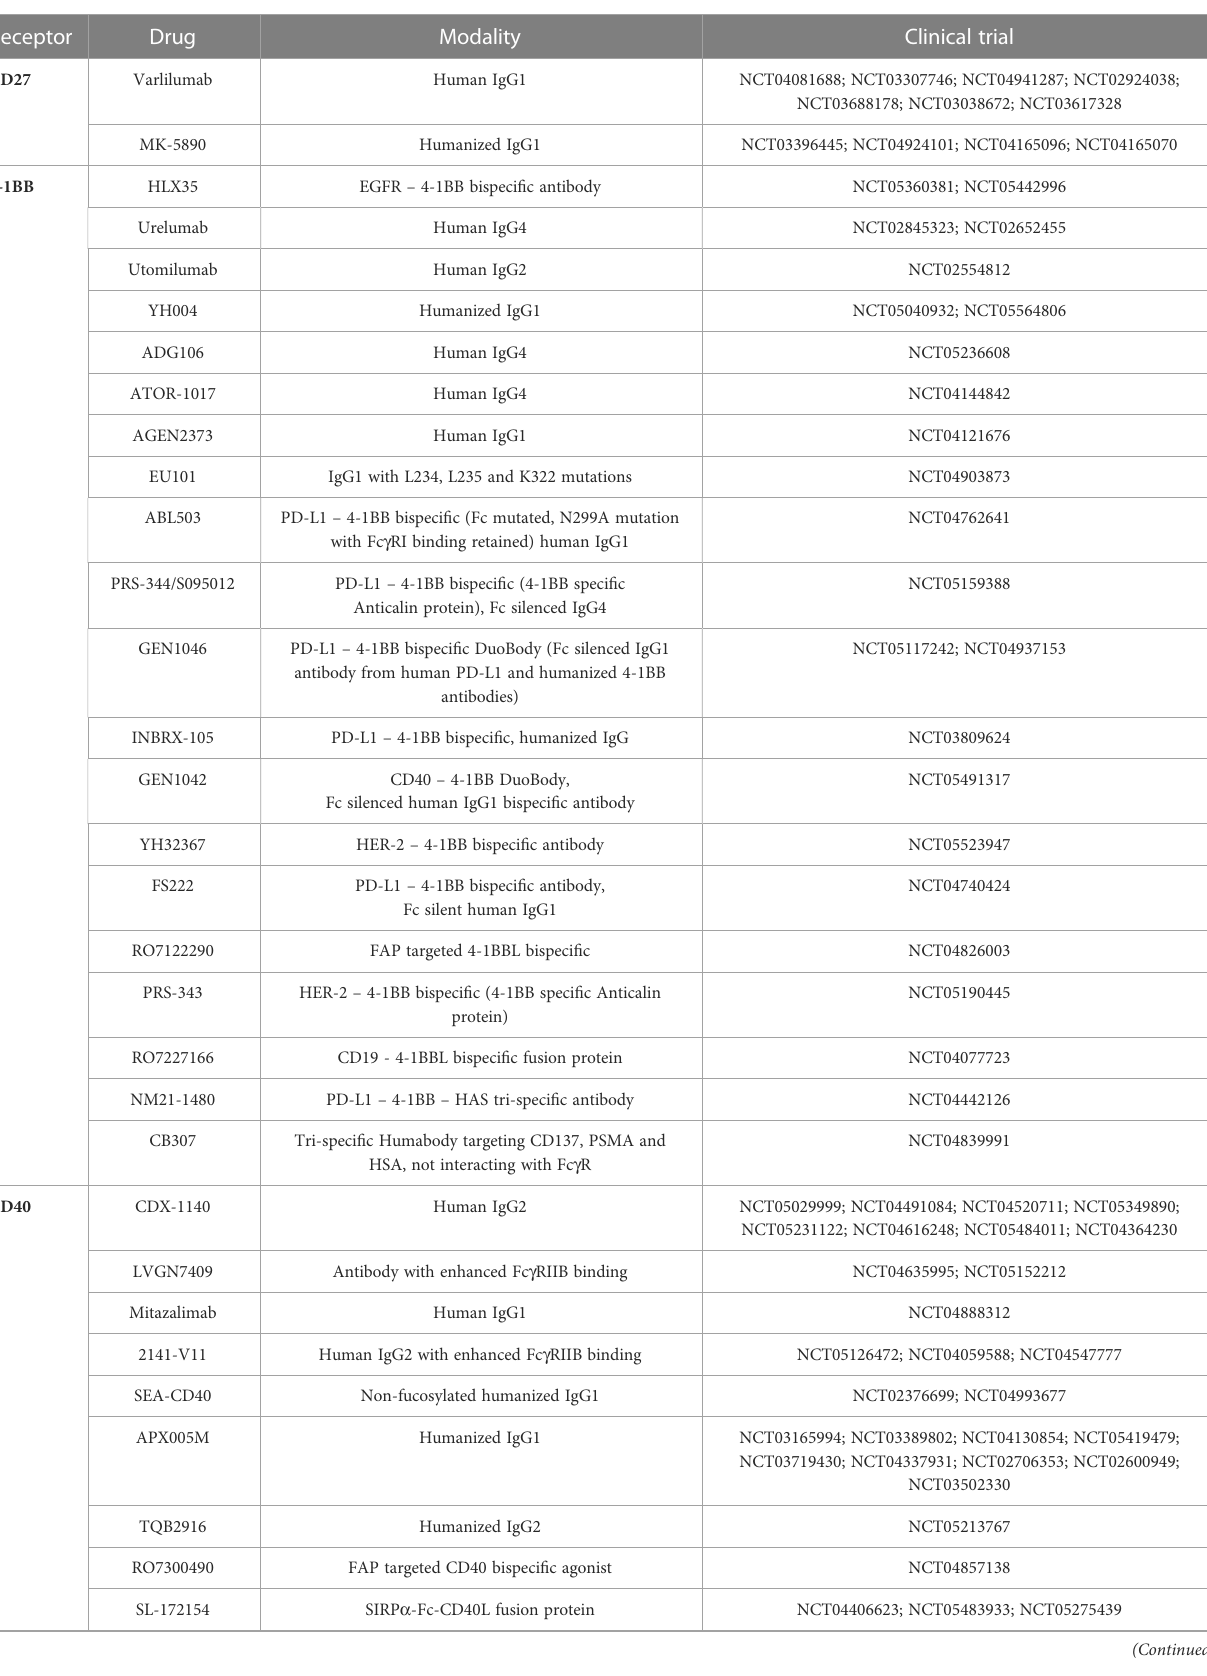
TABLE 2 Co-stimulatory TNFRSF targeting agents in clinical